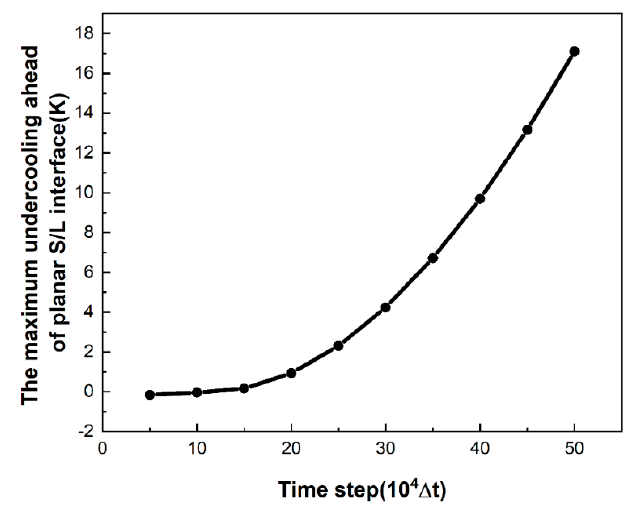
Figure 3. The variation of maximum undercooling ahead of planar S/L interface with time.